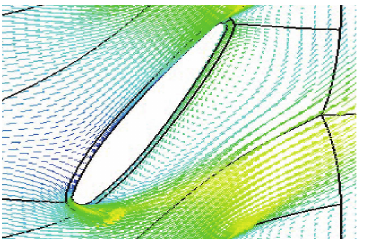
Figure 18: Velocity vector distribution of original profile at 60 ∘